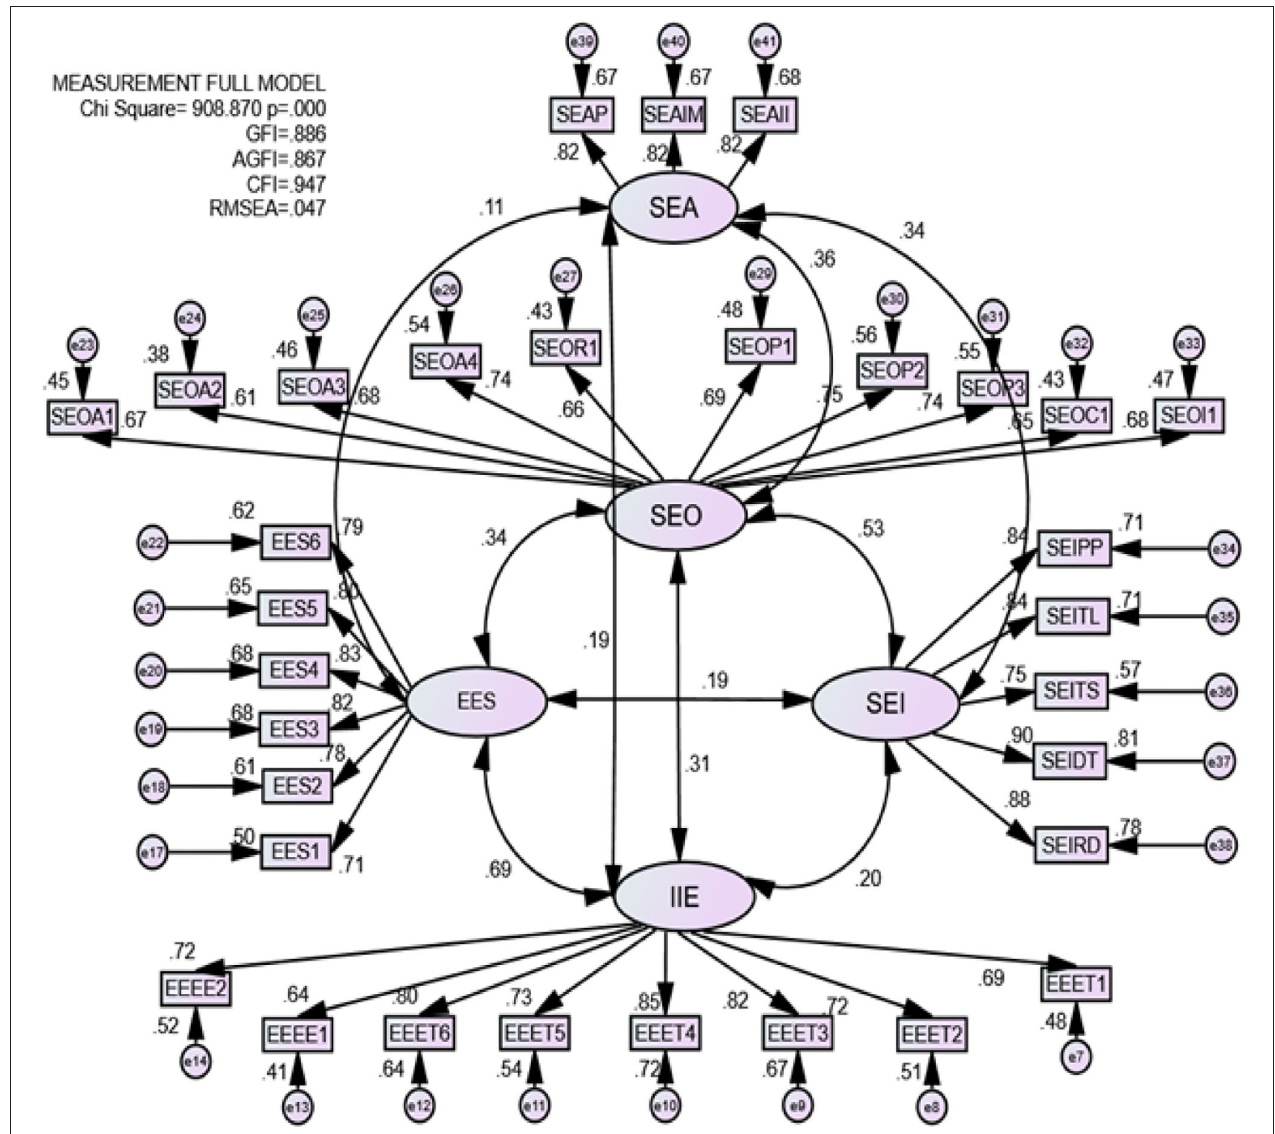
FIGURE 2 | Measurement model analysis.